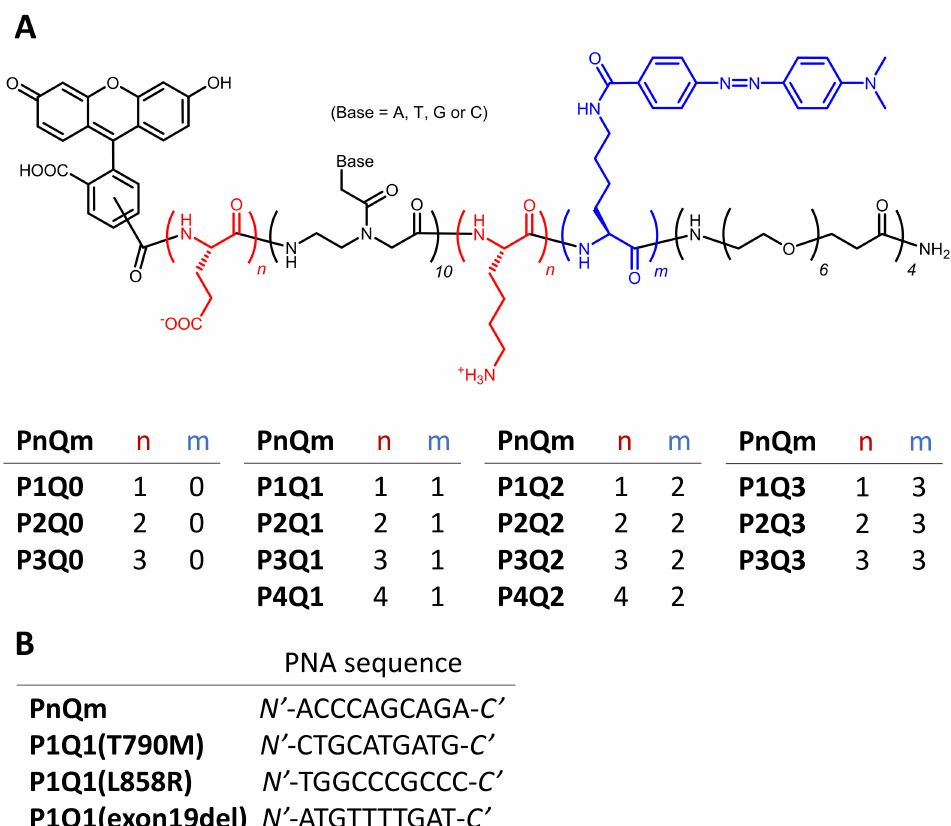
Figure 1. ( A ) Chemical structures of 14 PNA beacons ( PnQm (n = 1–4 and m = 0–3)) and three P1Q1 s with different PNA sequences: P1Q1(T790M) , P1Q1(L858R) , and P1Q1(exon19del) . The N-terminal and near C-terminal in the PNA beacon were modified with Fam and Dab quenchers, respectively. These PNA beacons were modified with four ethylene glycol linkers in the C-terminal to improve the water solubility. ( B ) The PNA sequences of PnQm s, P1Q1(T790M) , P1Q1(L858R) , and P1Q1(exon19del)